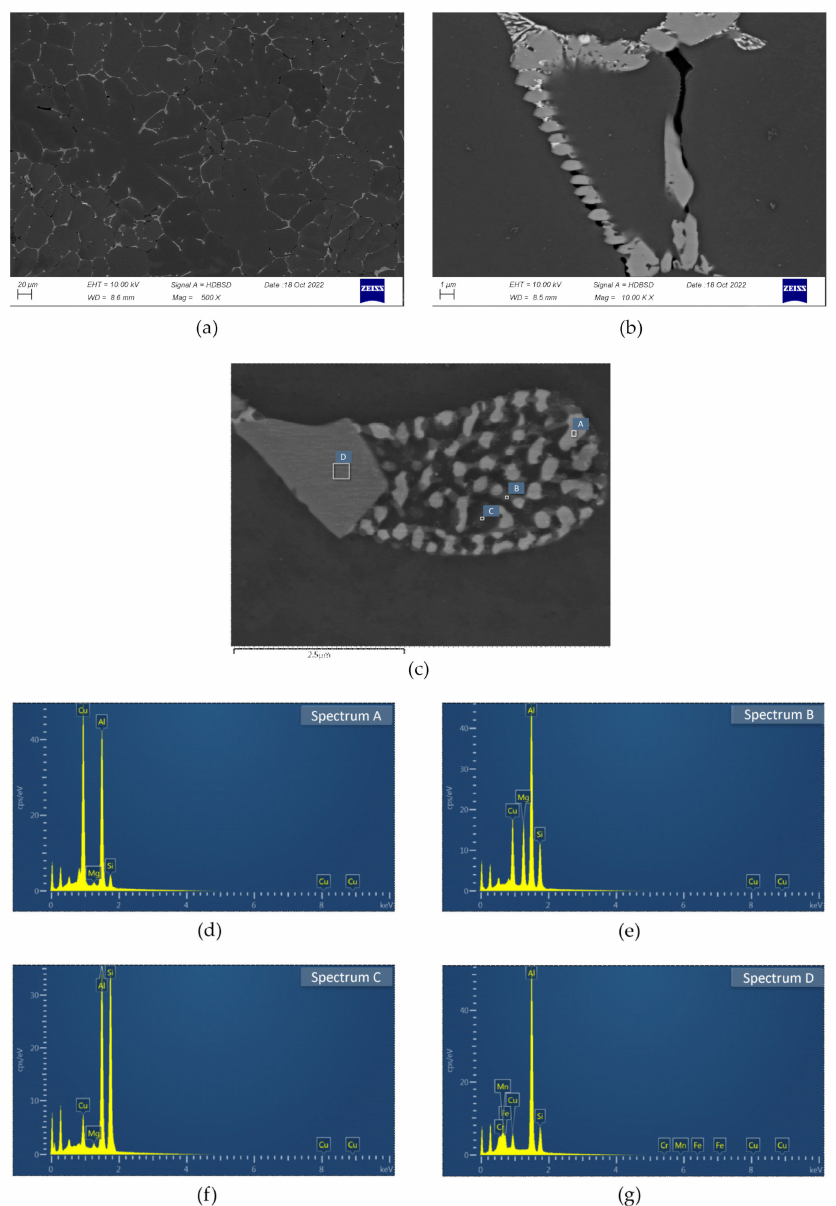
Figure 3. Microstructure of investigated alloy in as-cast state: ( a ) General view of the dendritic microstructure; ( b , c ) particles and eutectic areas; ( d – g ) spectra from panel